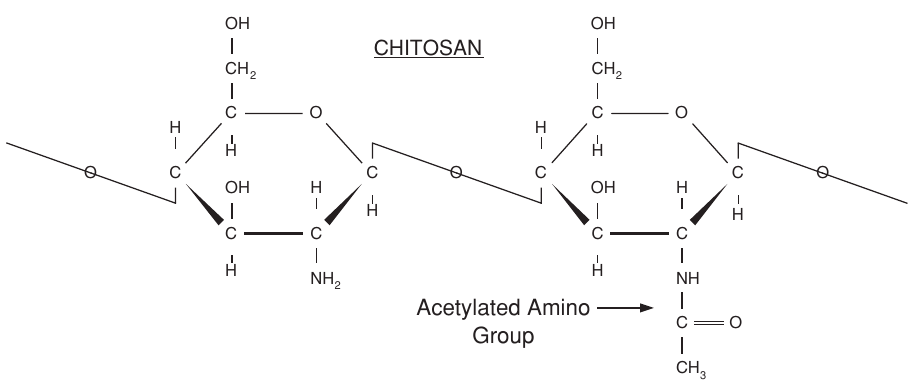
Figure 1 Chemical structure of